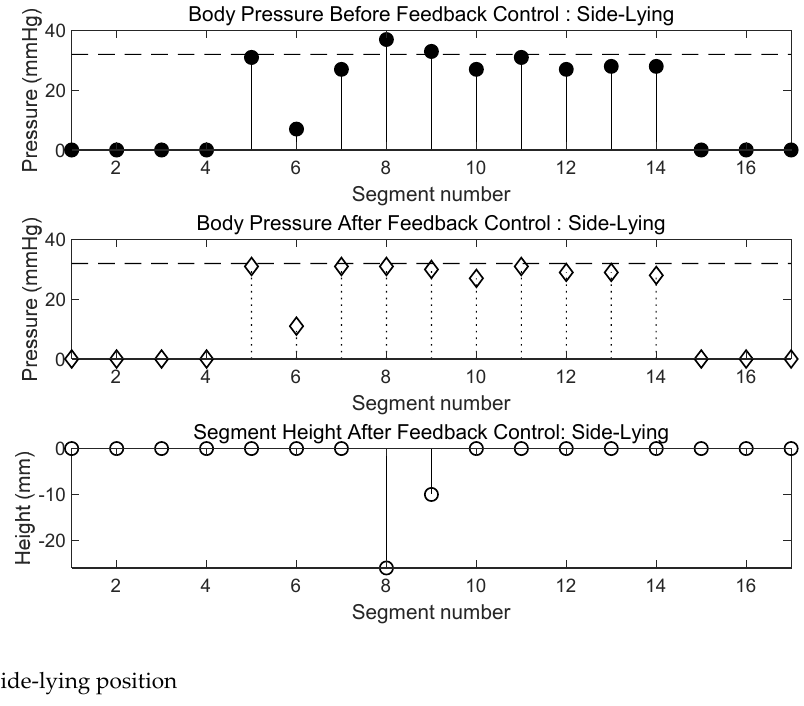
Figure 13 . Closed-loop control experiment results. Figure 14 shows the pressure errors of a segment in the supine and side-lying pos- tures under fuzzy control, where the x-axis represents the number of control iterations. According to the figure, the errors converge at zero. However, if the errors do not converge at zero within the predefined number of iterations, the controller enters the open-loop control mode.